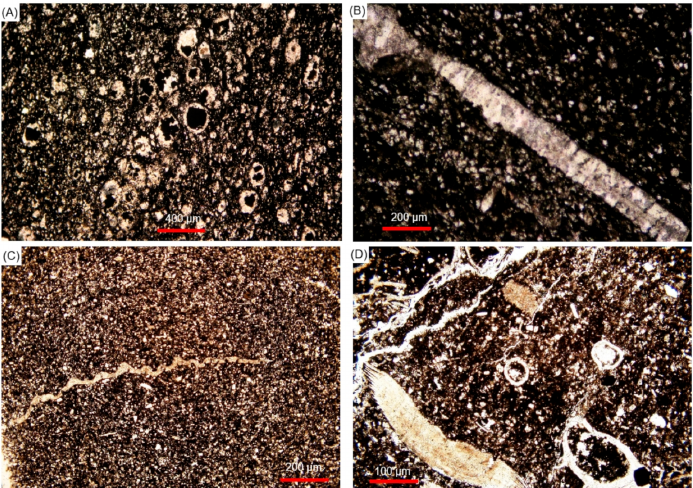
Figure 6. Standard thin section photos taken under orthogonal polarized light showing typical shale components from the Wufeng–Longmaxi shale in the Sichuan Basin of southwestern China. ( A ) Shale with abundant siliceous sponge fossils (Shuanghe outcrop in Changning County); ( B ) Shale with abundant sponge spicule (orthogonal polarization, Shuanghe outcrop in Changning County); ( C ) Shale with trilobite fossil fragments (Shuanghe outcrop in Changning County); ( D ) Shale with dense fossil fragments (Shuanghe outcrop in Changning